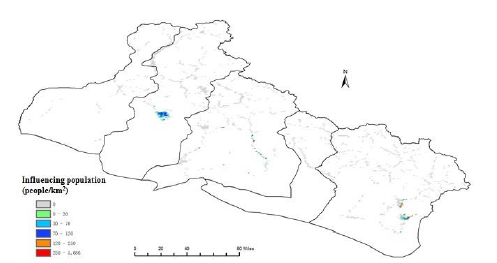
Figure 7. Population affected by the flood at a given time